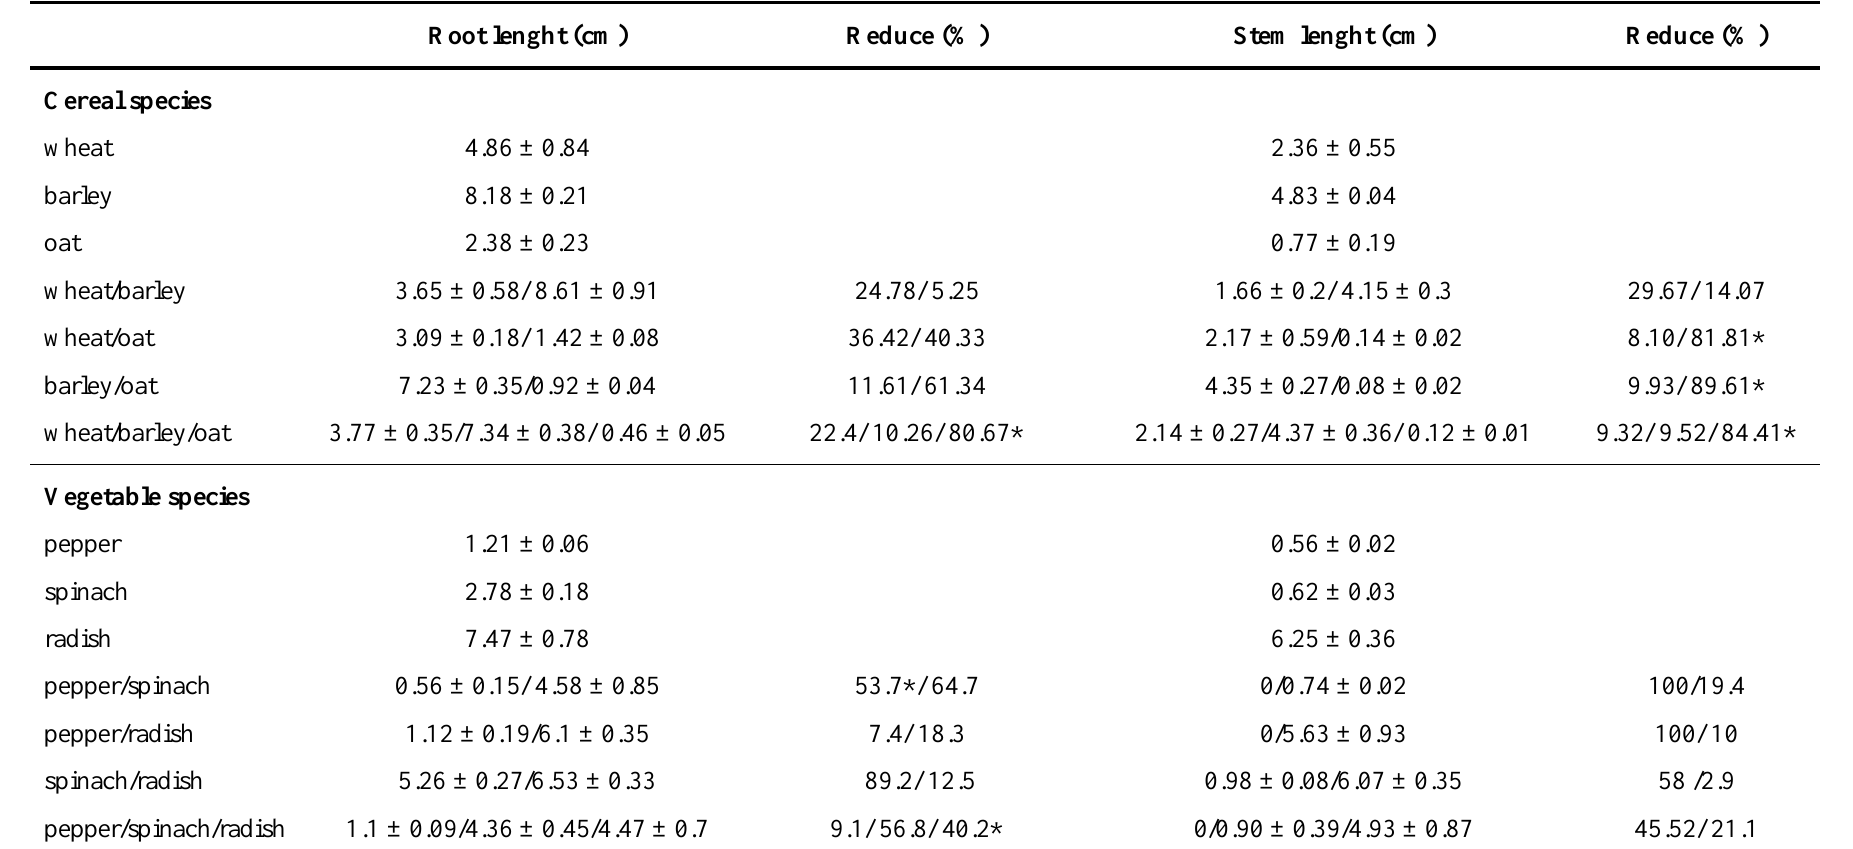
Table 1. Allelopathic effects of selected cereals and vegetables on growth